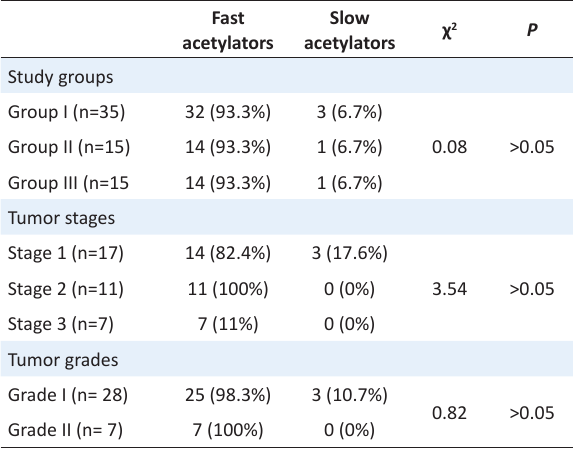
Table 5. Statistical comparison of NAT2 acetylation status between the study groups (group I, group II and group III), different stages and grades of bladder cancer using chi-square